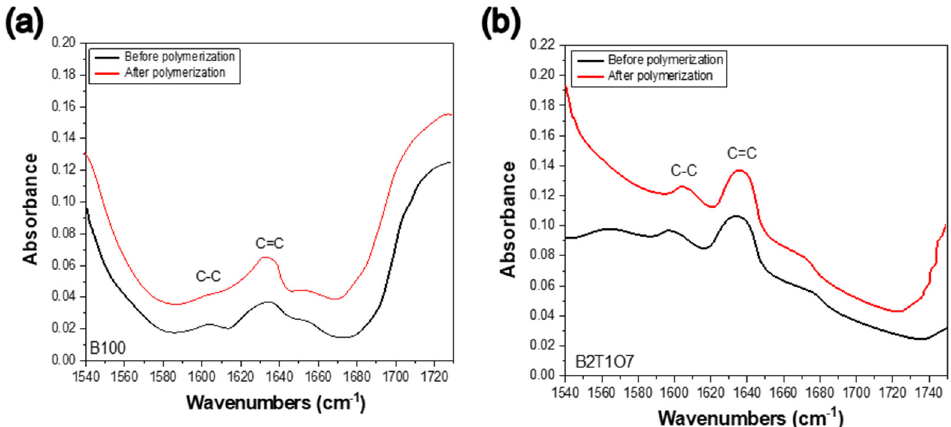
Figure 3. FT-IR spectra before and after light polymerization showing typical C − C and C=C peaks by. ( a ) B100, ( b ) B2T1O7.